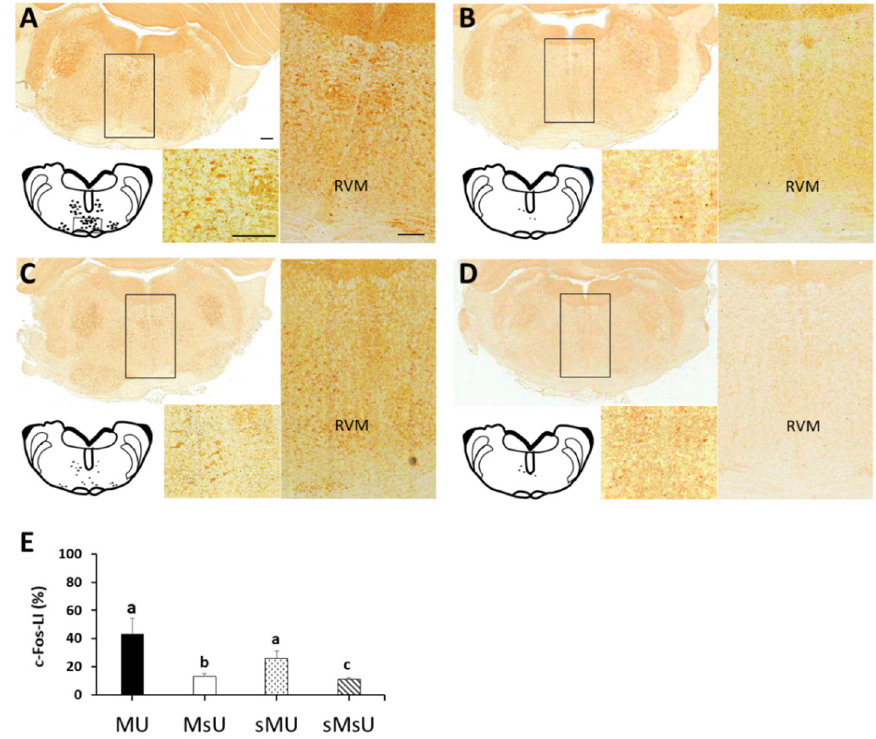
Figure 5. Representative c-Fos-LI staining in sections of rostral ventromedial medulla (RVM) in rats of MU ( A ), MsU ( B ), sMU ( C ), and sMsU ( D ) groups. The c-Fos-LI staining areas are higher in RVM of MU group than of other groups. Data of c-Fos-LI in RVM are presented as mean ± SD and values with different superscripts (e.g., a vs. b and b vs. c) indicate significant differences ( p < 0.0083) for all possible pairwise comparisons of means tested by Mann-Whitney tests ( E ). Scale bars, 250 μ m.